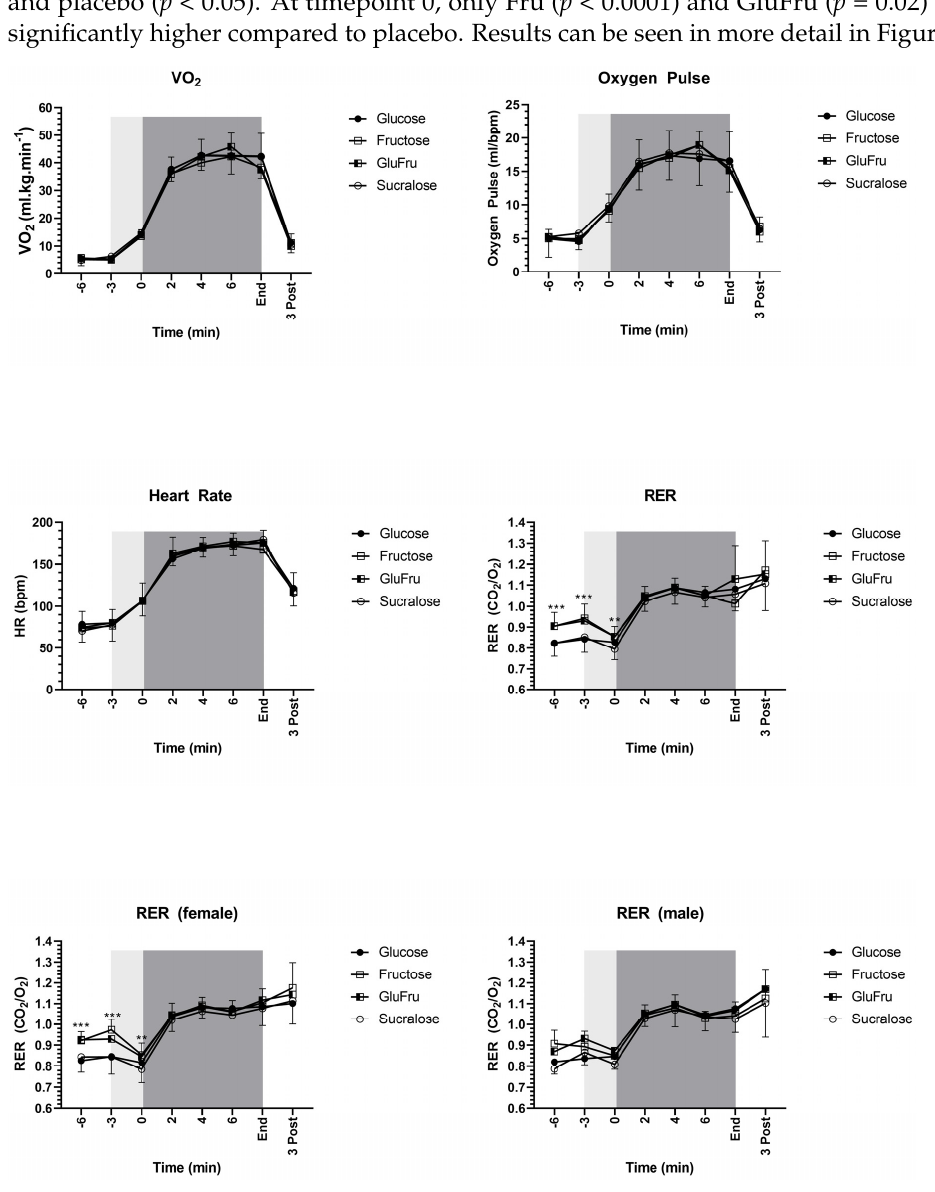
Figure 4. Black circles indicate Glu. Open Squares indicate fru. Half open squares indicate GluFru. Open circles indicate sucralose. Light grey areas indicate warm up periods. Dark grey areas indicate exercise testing. Parameters derived from cycling study visits. VO 2 : Oxygen consumption. CO 2 : Carbon dioxide production. RER: Respiratory exchange ratio. HR: Heart rate. *** indicates statistical significance between fructose and GluFru compared to glucose and placebo. ** indicates statistical significance between fru and Glufru compared to